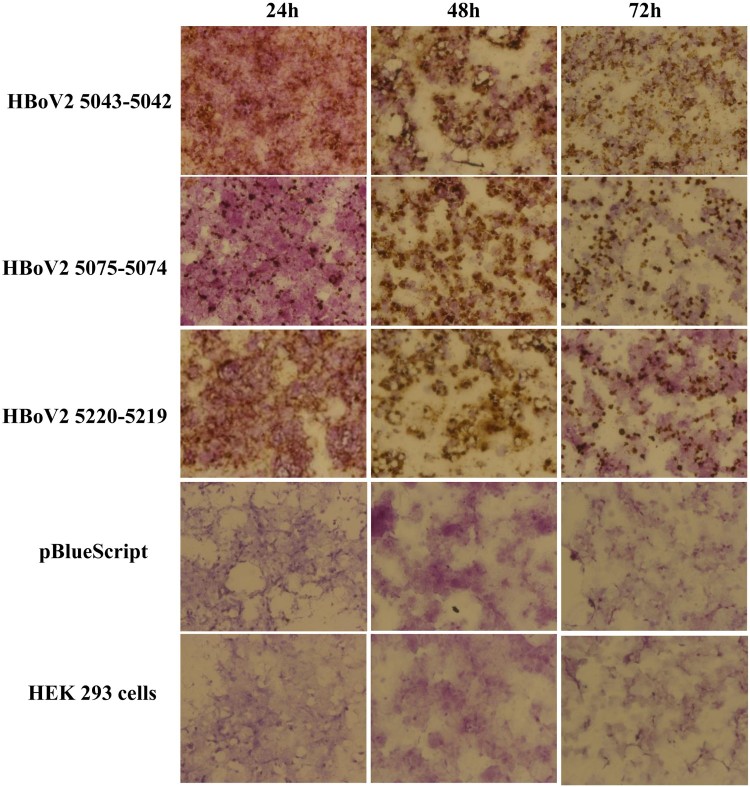
ISH staining of hetero-HBoV2 mRNA transcripts. A: HEK293 cells transfected
with plasmid pBlueScript-HBoV2 5043–5042; B: HEK293 cells transfected with plasmid
pBlueScript-HBoV2 5075–5074; C: HEK293 cells transfected with plasmid
pBlueScript-HBoV2 5220–5219; D: HEK293 cells transfected with pBlueScript; E:
Untreated HEK293 cell control. 24 h, 48 h, 72 h denote 24, 48 and 72 h
post-transfection, respectively.